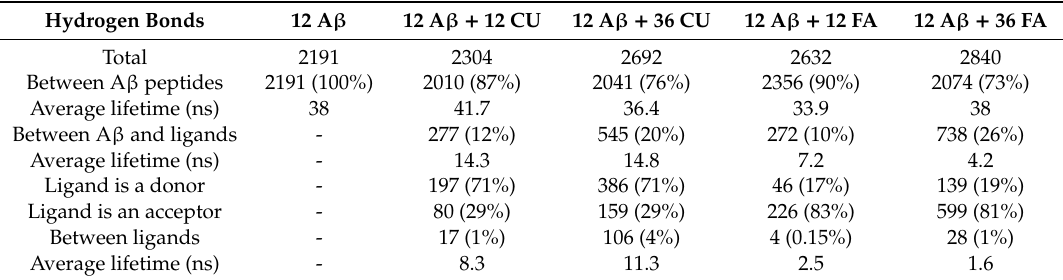
Table 1. Number, percentage, and lifetime of hydrogen bonds formed between A β peptides, between A β peptides and ligands, and between ligands calculated over 1000 frames (1000